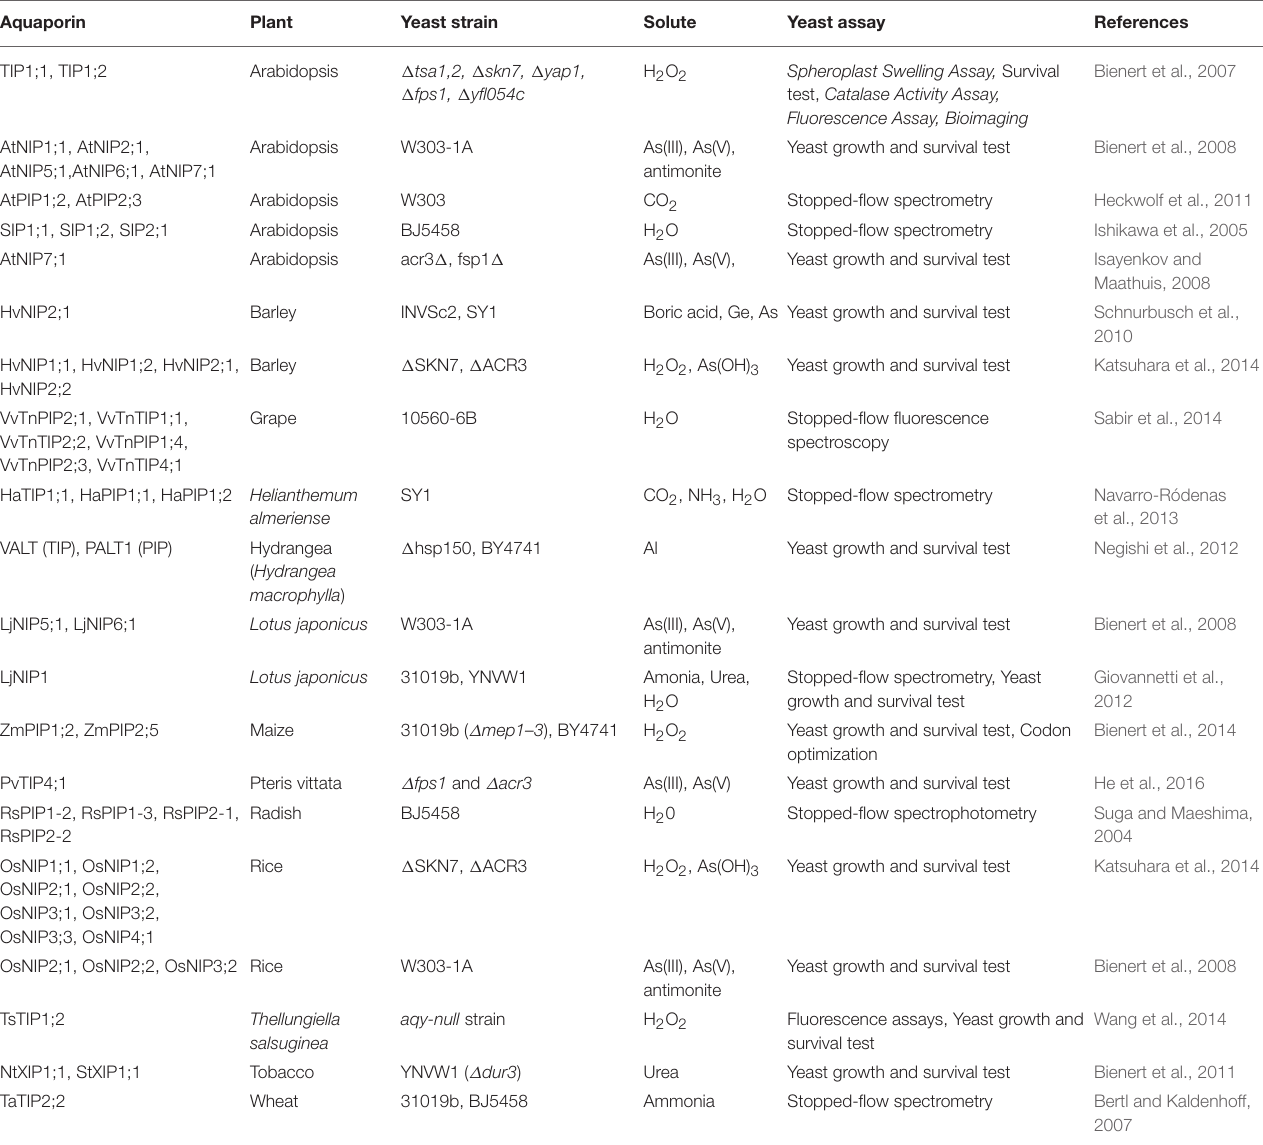
TABLE 4 | List of plant aquaporins evaluated for transport of different solutes using yeast